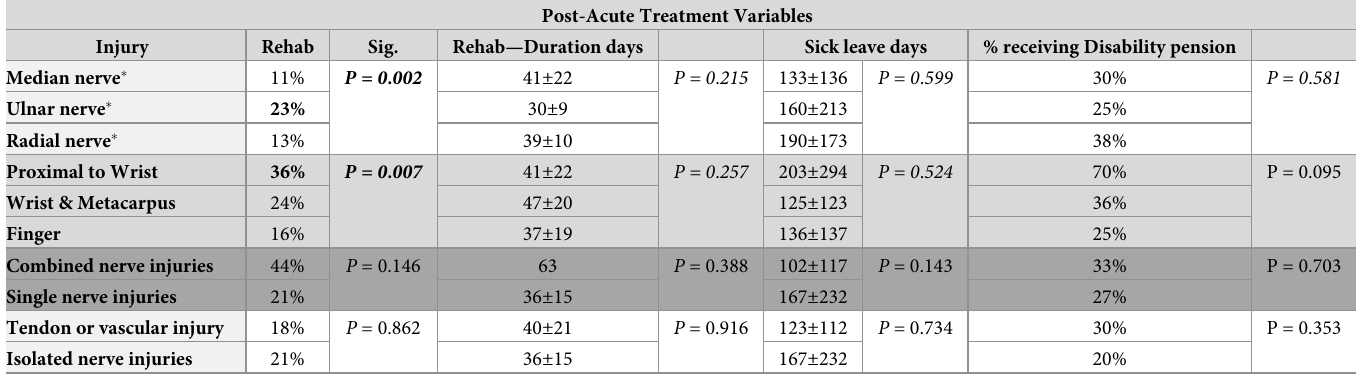
Table 2. Various aspects following acute treatment in relation to injured nerve, injury location and concomitant nerve, vascular or tendon injury. Interestingly, there is a significant increase for rehabilitation in patients with ulnar nerve injury and proximal nerve injuries. The surprisingly low number of rehabilitations in concomi- tant tendon or vascular injury is likely due to the high prevalence of very distal finger nerve injuries. Likewise, for nerve injuries proximal to the wrist, there is a high per- centage of disability pension, which was however not quite statistically different. The column disability pension refers to percentage of reduced work ability, patients suffered as a consequence of the nerve injury. All P-Values were calculated using Kruskal-Wallis